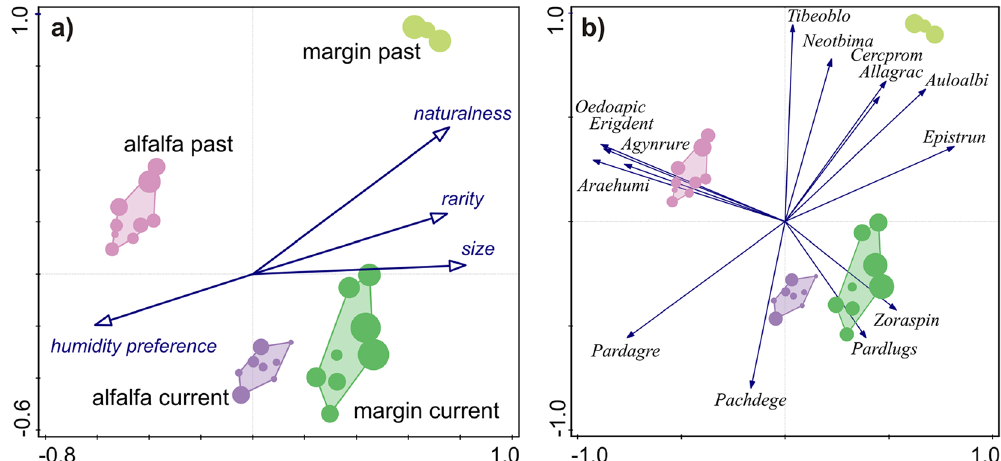
Figure 3. Unconstrained ordination (PCA) of sampling sets in the two studied habitats belonging to the current or past study period (identity of sampling set groups is colour coded and labelled on the figure. Dot size indicates species richness of the sampling sets. ( a ) Community weighted mean species characteristics as supplementary variables are depicted as a biplot; ( b ) the most influential species are depicted as a biplot on the PCA diagram. Species abbreviations are as follows: Agynrure— Agyneta rurestris ; Allagrac— Allagelena gracilens ; Auloalbi— Aulonia albimana ; Cercpromi— Cercidia prominens ; Epistrun— Episinus truncatus ; Erigdent— Erigone dentipalpis ; Neotbima— Neottiura bimaculata ; Oedoapic— Oedothorax apicatus ; Pachdege— Pachygnatha degeeri ; Pardagre— Pardosa agrestis ; Pardlugu— Pardosa lugubris s.str.; Tibeoblo— Tibellus oblongus ; Zoraspin— Zora spinimana